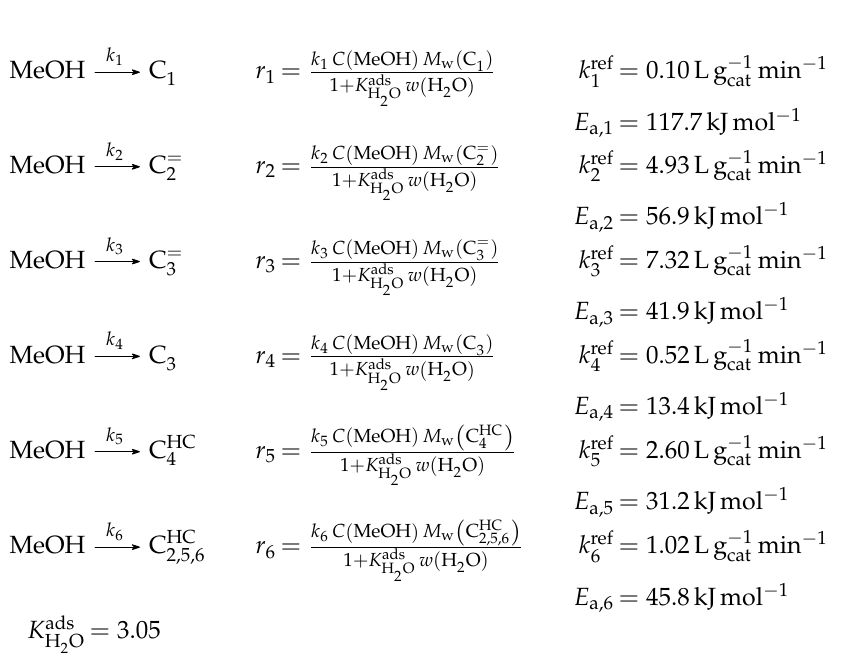
Scheme 31. Reaction network, rate equations and estimated parameters for the model by Ying et al. [256]. An overview of the net rates of formation can be found in Scheme